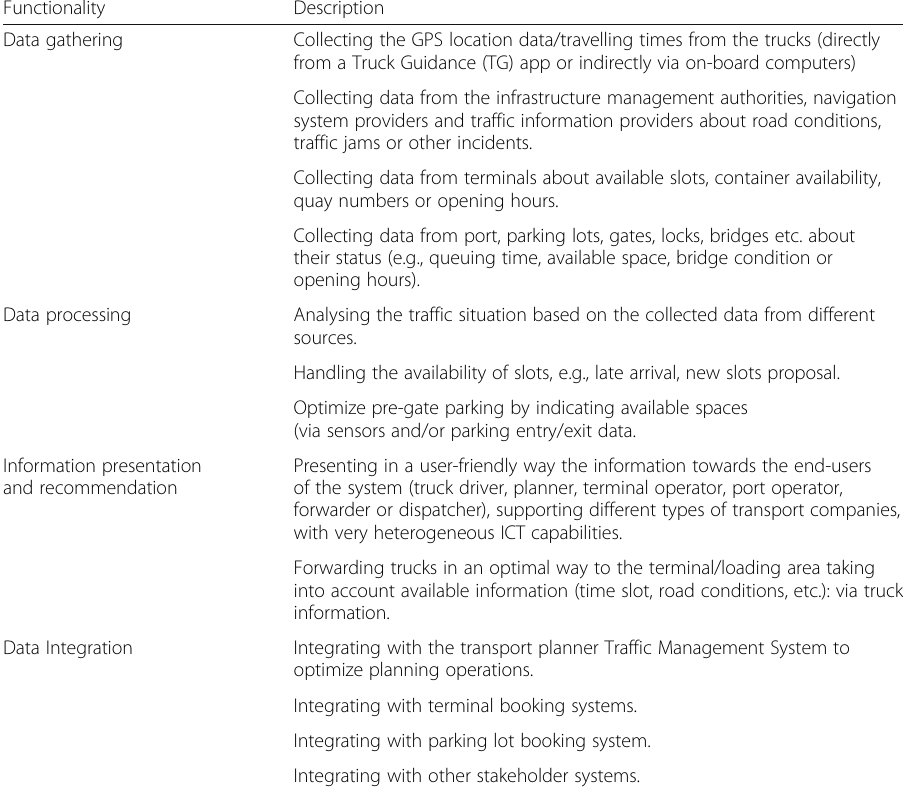
Table 2 TGS functionalities [Source: own composition based on interviews results] Functionality